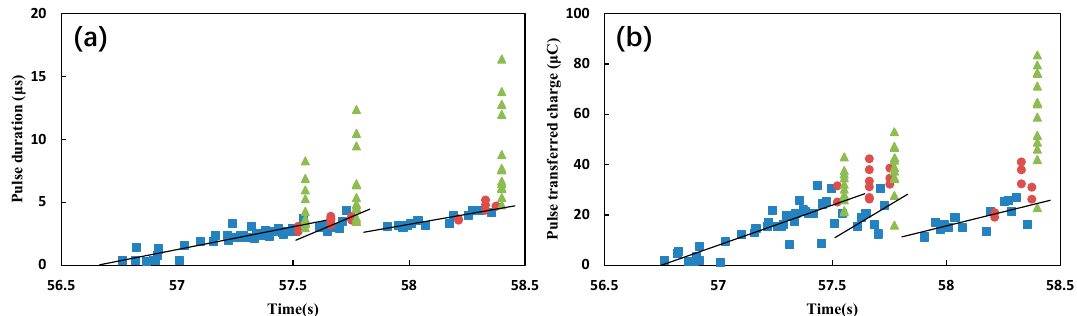
Figure 5. Graph of pulse duration ( a ) and transferred charge ( b ) of triggered lightning 570 over time. Blue squares represent PCPs, red circles represent PCP clusters, green triangles represent IPCPs and the black line is the linear fitting line of the PCPs.